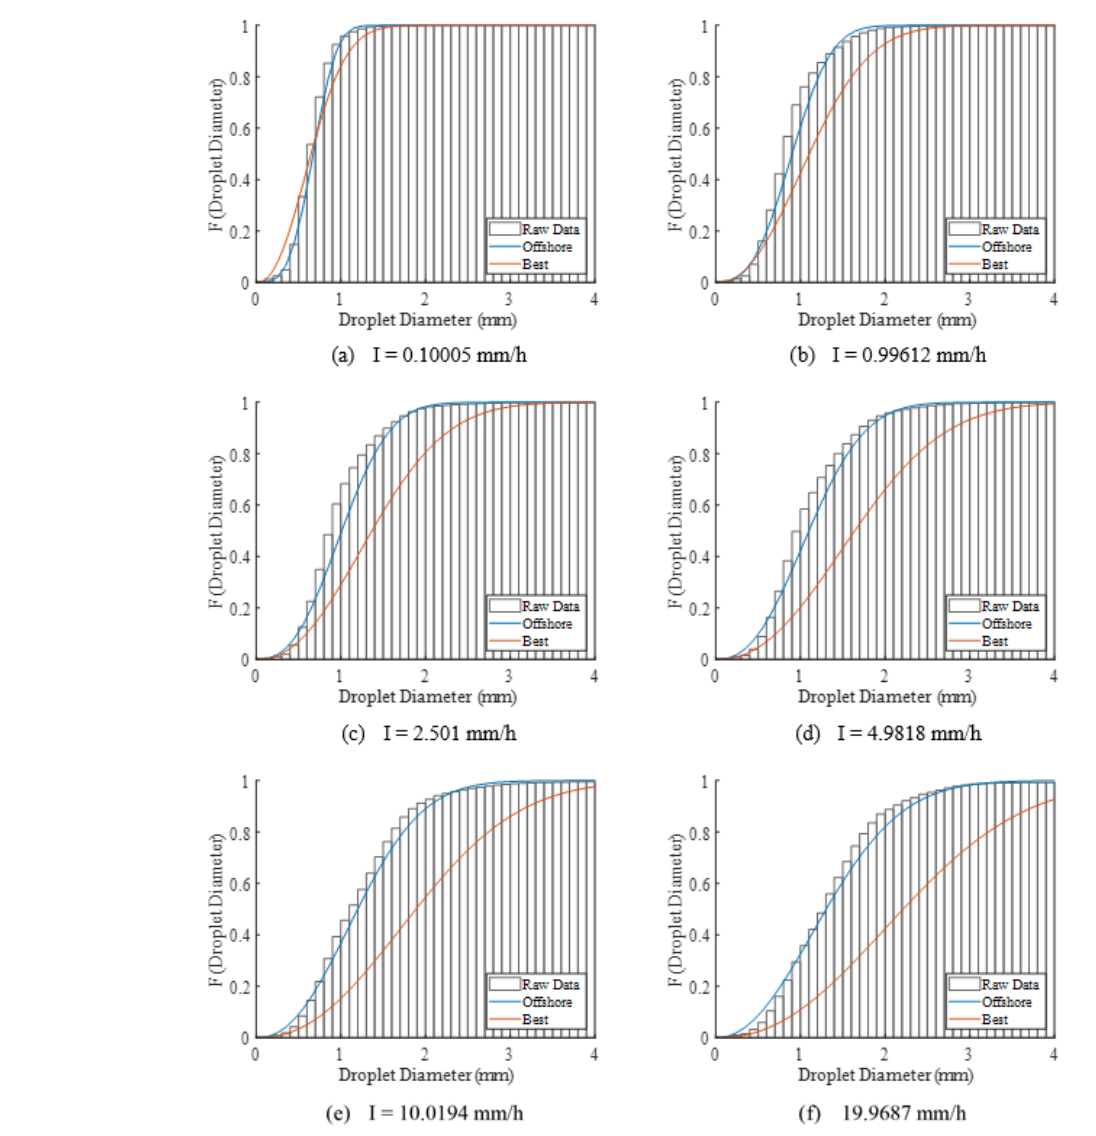
Figure 10. Comparison between the offshore DSD and the Best DSD at precipitation intensities (a) 0.10005, (b) 0.99612, (c) 2.501, (d) 4.9818, (e) 10.0194 and (f) 19.9687mmh − 1